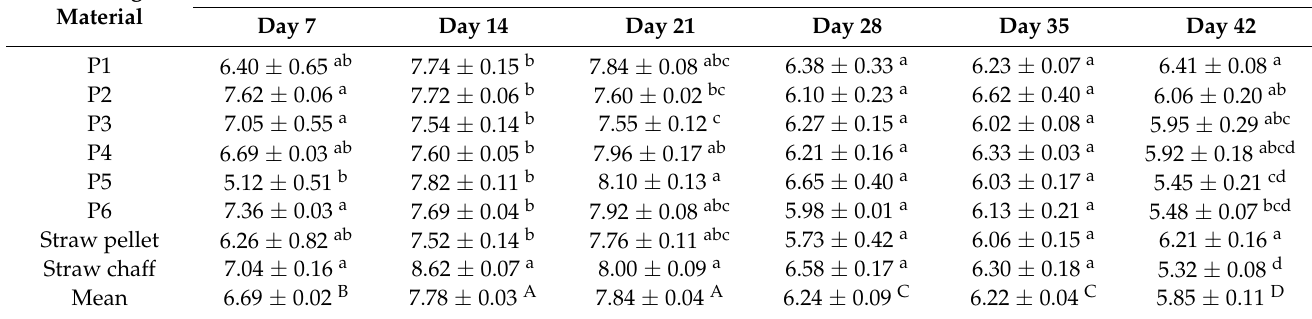
Table 8. Changes in the count of total yeast and moulds in the bedding material during use under operating conditions—2nd experimental